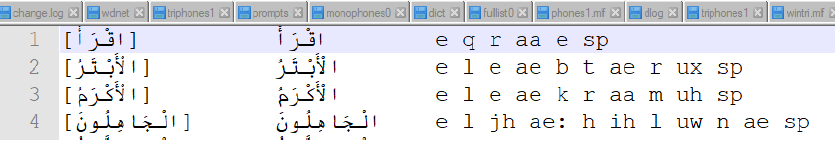
Figure 4. Sample of Arabic Dictionary.